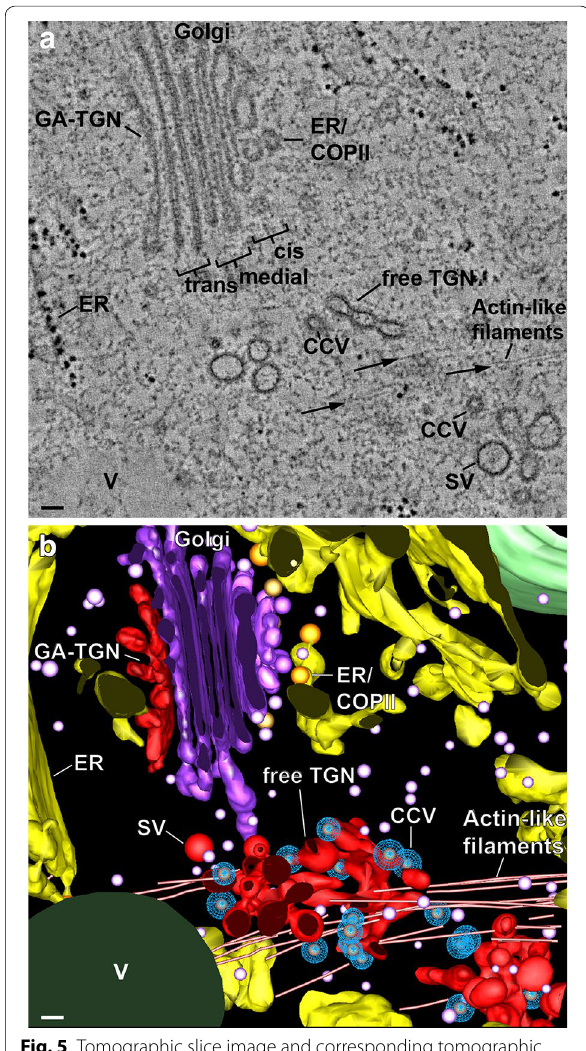
Fig. 5 Tomographic slice image and corresponding tomographic model of a Golgi stack and TGN cisternae with associated actin-like filaments (arrows) in a 1 day-induced gland cell. a Tomographic slice image illustrating differences in architecture and staining of cis, medial and trans Golgi, Golgi-associated trans Golgi network (GA-TGN) and free trans Golgi network TGN cisternae, an ER cisterna with a budding COPII vesicle (ER/COPII), clathrin-coated vesicles (CCV), and secretory vesicles (SV). The actin-like filaments associated with the free TGN cisternae are a unique feature of the 1 day BSA-induced cells. b 3D tomographic model of the structures illustrated in a . The filaments are organized in the form of a loose bundle around the free TGN cisternae (only one 1 day-induced sample was analyzed in this study). Vacuole (V). Bars 0.1